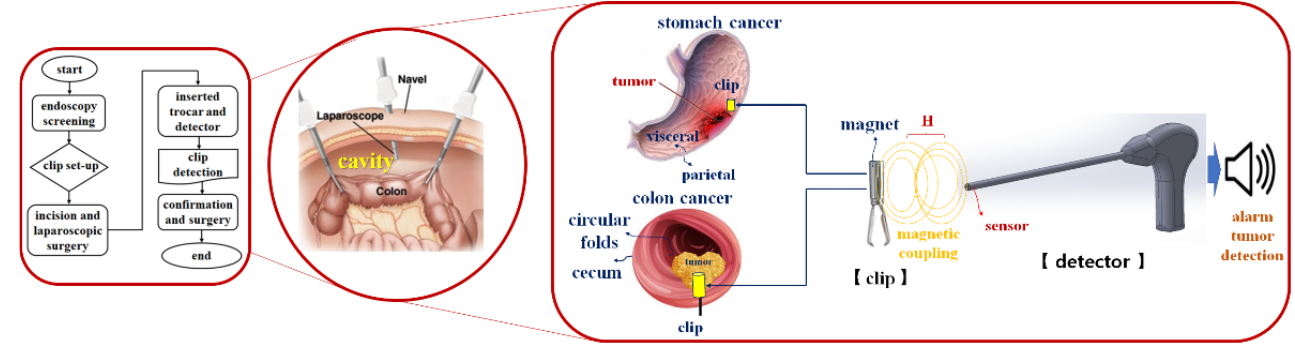
Figure 1. Process of tracking with tumor localization using the clip–detector.